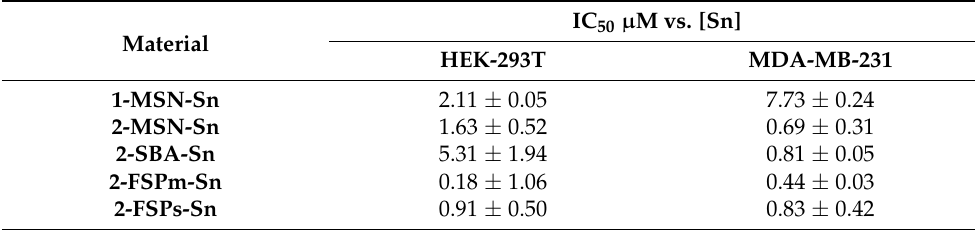
Table 4. Cytotoxic activity values of all the final materials calculated as a IC 50 function of the metallic load ( µ